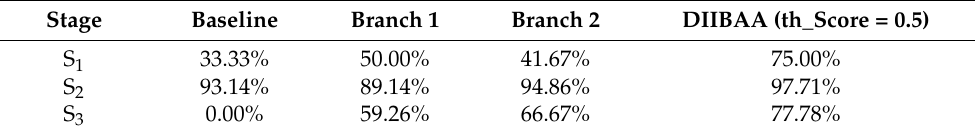
Table 6. Results on male.